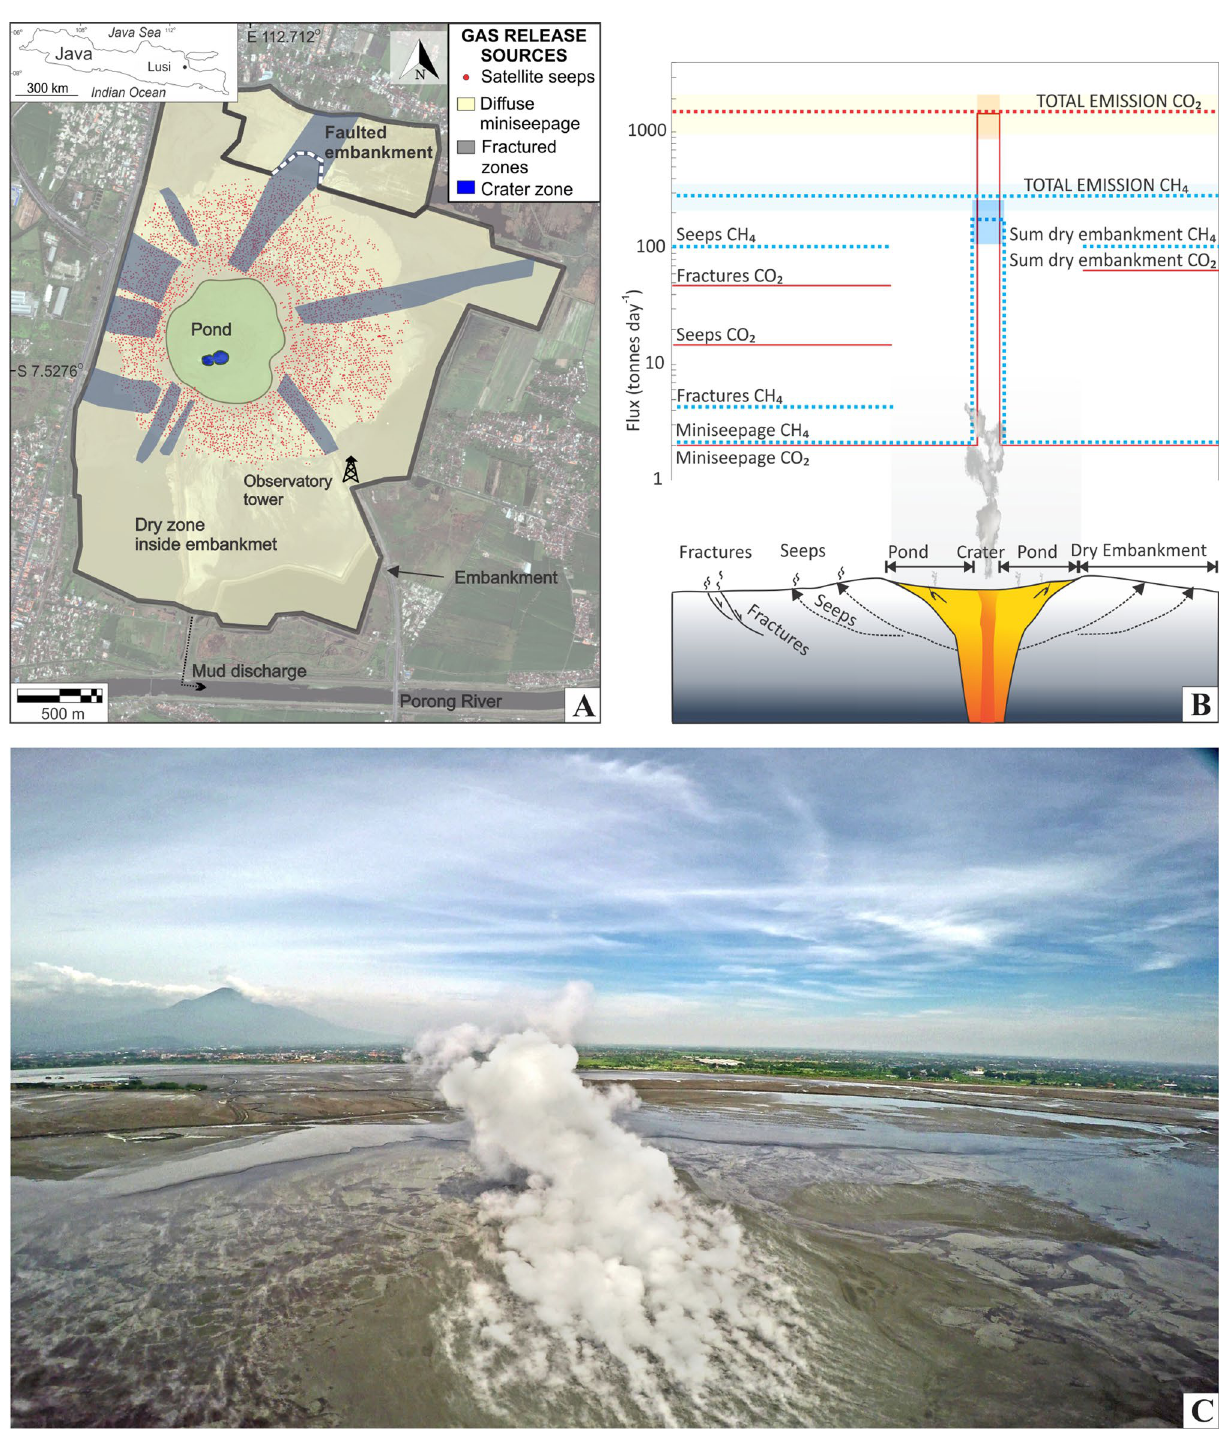
Figure 1. Gas emissions at Lusi site. ( A ) High resolution Ikonos satellite image of Lusi area in August 2014; Additional details, exported from basemap obtained from Esri ArcGIS ArcMap 10.2.1 and overlaid using Corel Draw X7, indicate the main features and the gas release sources identified in the region. Inset map of Java Island with indicated Lusi location. ( B ) Detailed outputs of gas emissions from the different sources around the eruption site. ( C ) Drone view of the plume during its regular geysering activity. The second vent is behind the main one and the Arjuno-Welirang volcanic complex in the background. The inaccessible 650 m in diameter pond surrounding the crater zone is filled by hot mud and laterally extensive oil